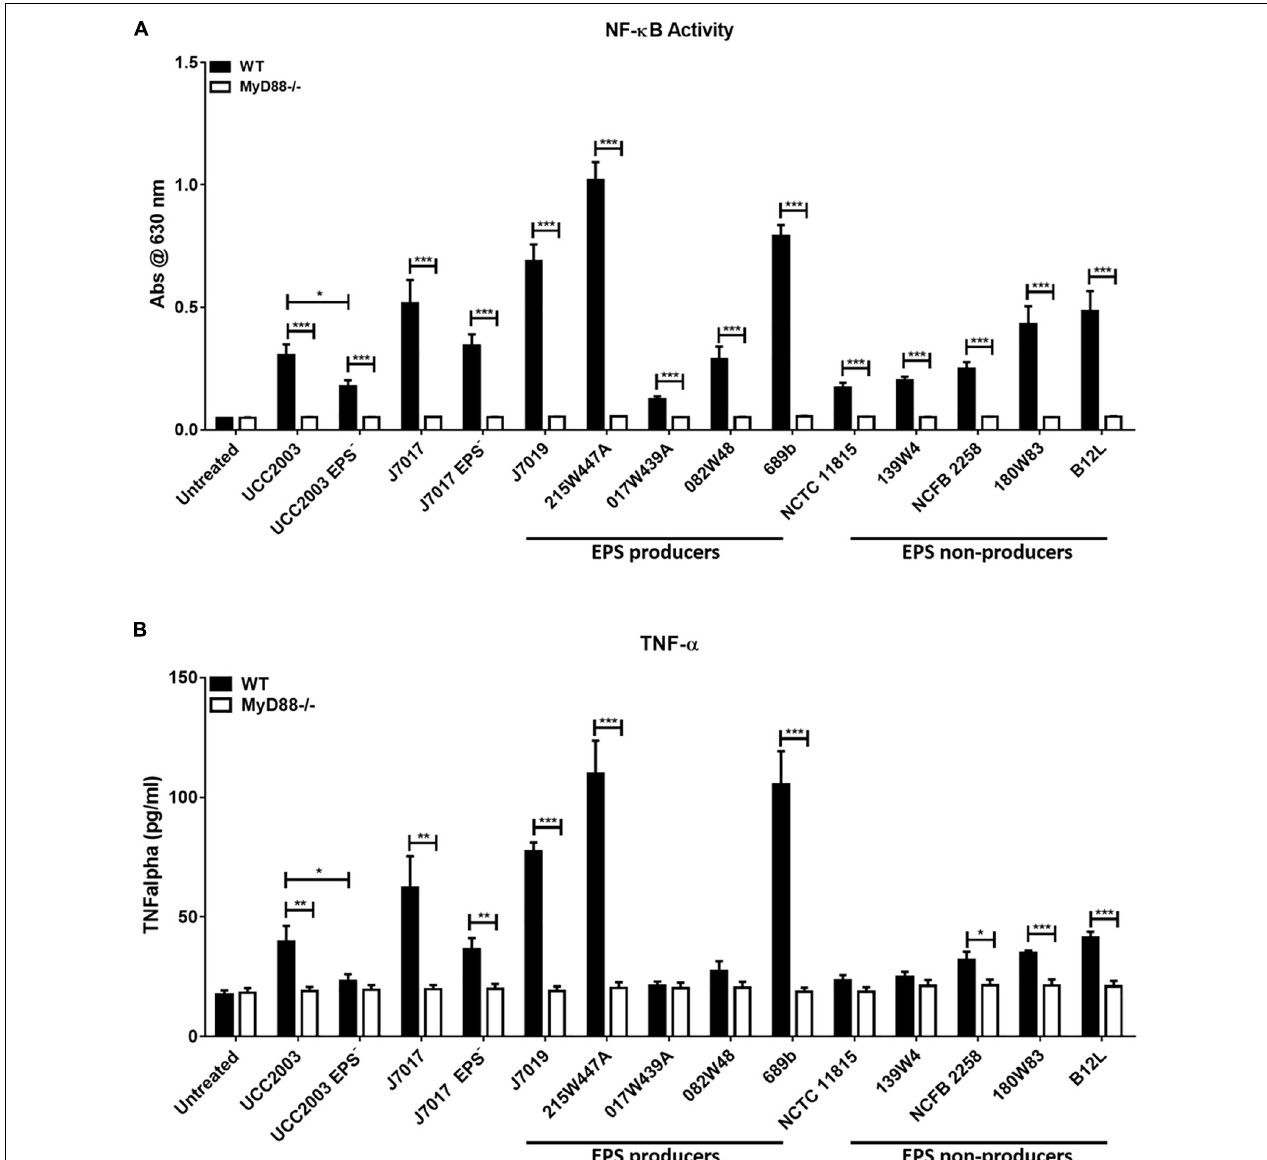
FIGURE 2 | Human THP-1 monocyte responses to B. breve strains are MyD88-dependent but EPS-independent. B. breve strains were incubated with THP1-XBlue and THP1-XBlue-defMyD reporter cell lines for 24 h. (A) NF- κ B responses were assessed by measuring reporter gene production, secreted embryonic alkaline phosphatase. (B) TNF- α secretion was assessed by ELISA. Data shown is the average of three independent experiments performed in triplicate wells. Data are presented as mean ± SEM. Statistical analysis was assessed using the student t -test in GraphPad Prism where * p -value < 0.05, ** p -value < 0.005, and *** p -value <